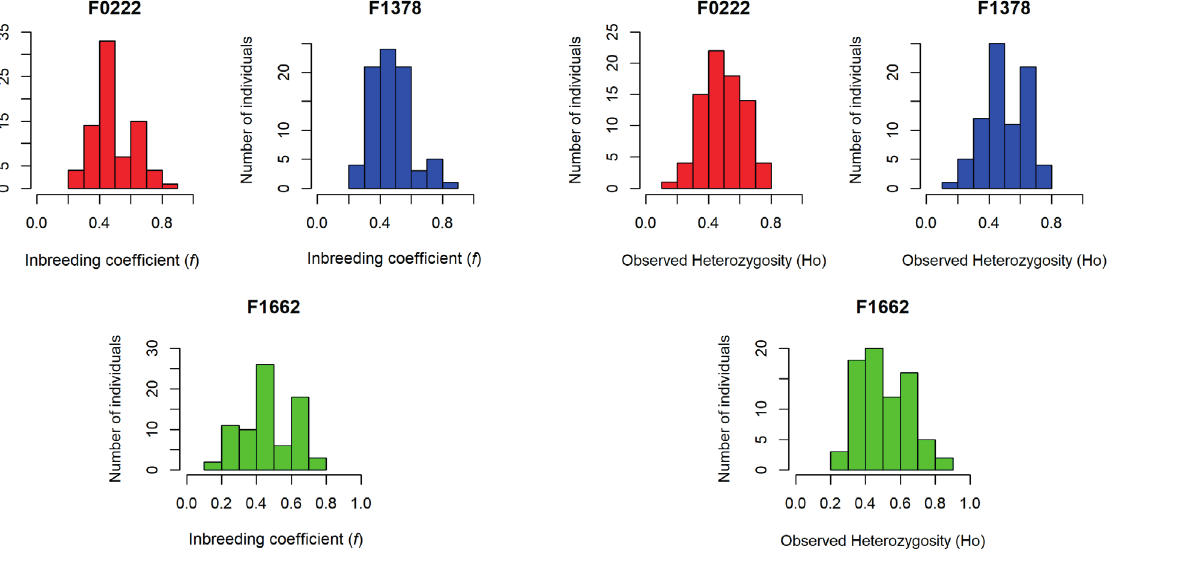
Minimum, maximum and average values of observed heterozygosity (Ho) and inbreeding coefficient ( f ) in S individuals from different self-pollinated progenies. Progeny Parameter Minimum Maximum